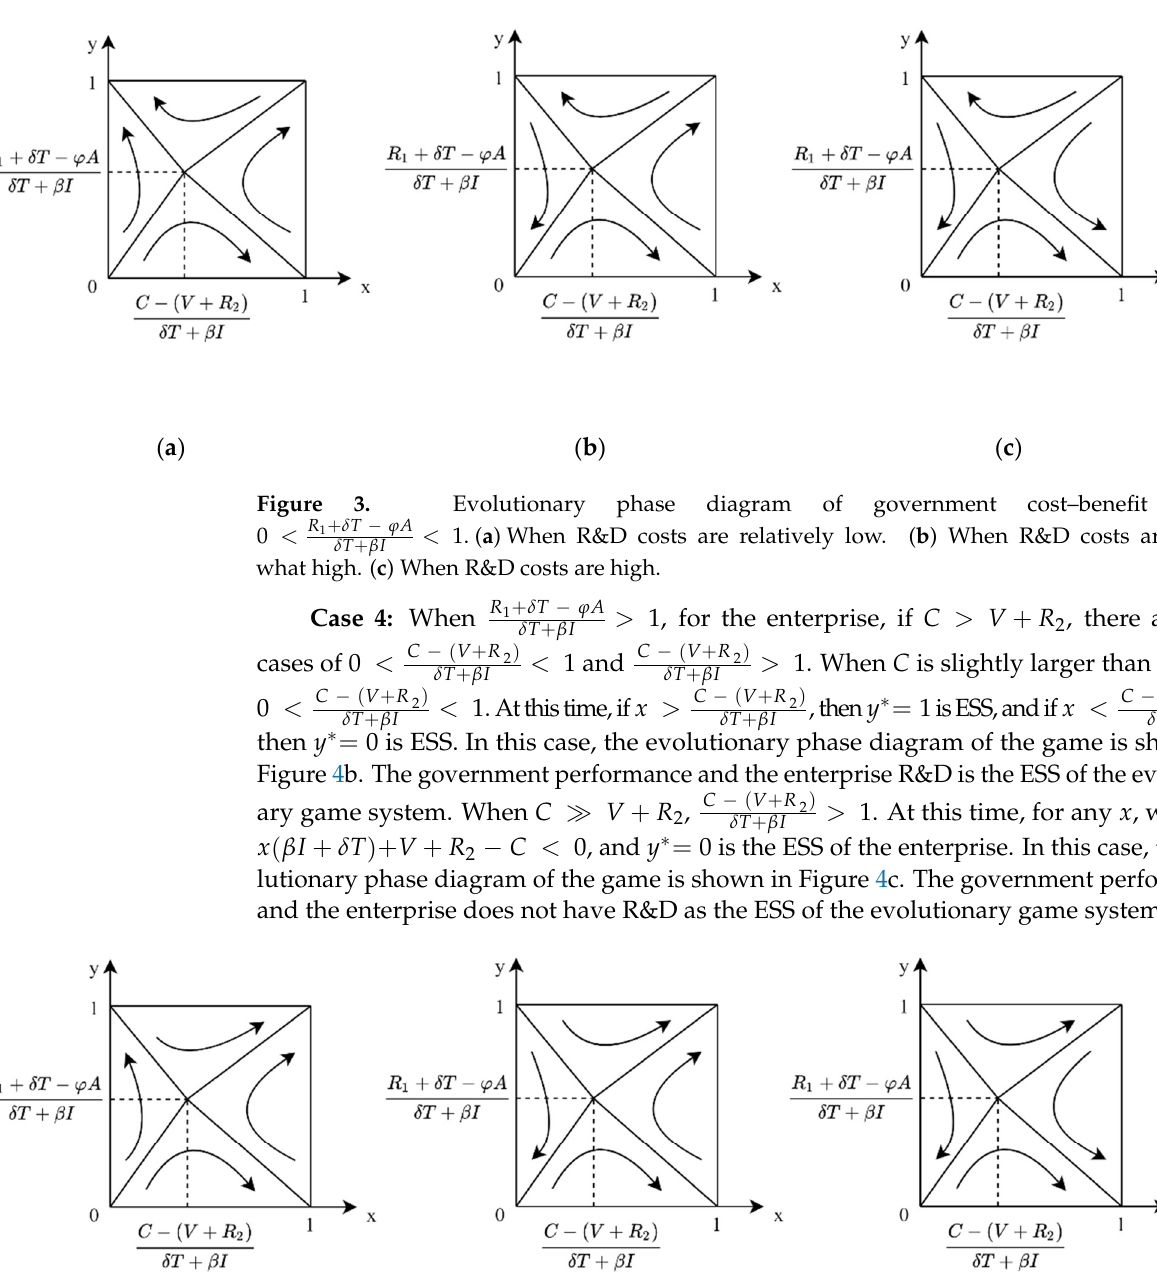
> 1 . ( a ) When > 1. ( a ) When δ T + β I δT + βI